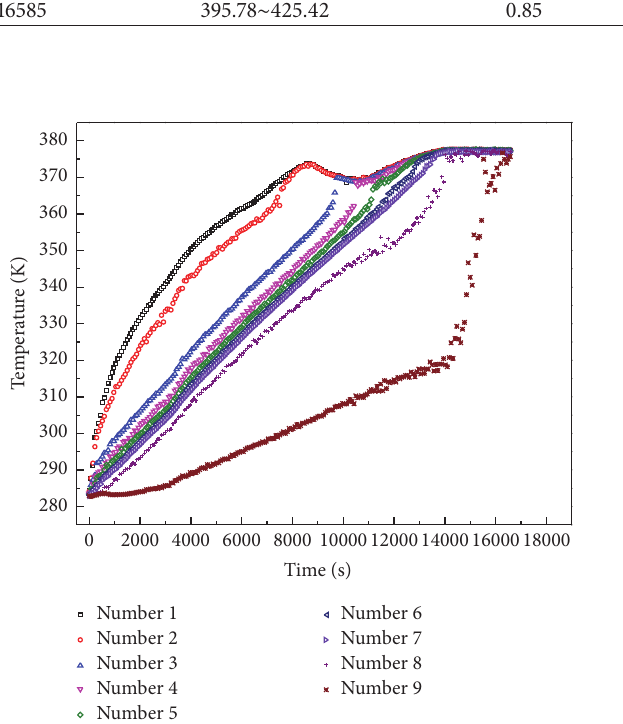
Figure 3: Temperature distribution in the vertical direction of the water tank.